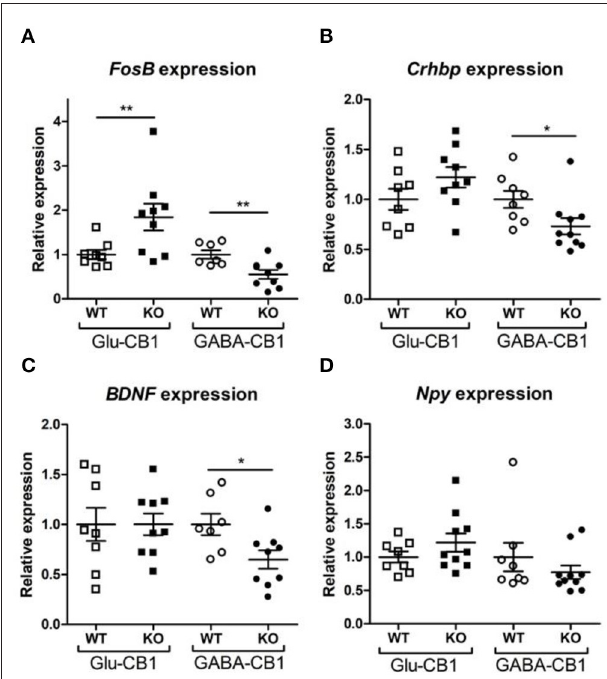
FIGURE 4 | Relative expression of genes of interest after open field exposure measured via RT-qPCR. The measurements were performed with independent samples ( n = 7–9 replicates per group) to validate the results from our RNA-seq experiment. Genes that showed a potential dichotomy between the comparisons of both mouse lines were selected for further validation. (A) Expression levels of FosB proto-oncogene, AP-1 transcription factor subunit. (B) Expression levels of corticotropin-releasing hormone binding protein (Crhbp). (C) Expression levels of brain-derived neurotrophic factor ( BDNF ). (D) Expression levels of neuropeptide Y ( Npy ). The expression levels were normalized using β -actin as housekeeping gene. Bars represent mean ± S.E.M. Unpaired t -Test with Welch’s correction when variances between groups were different. * p < 0.05; ** p < 0.01.